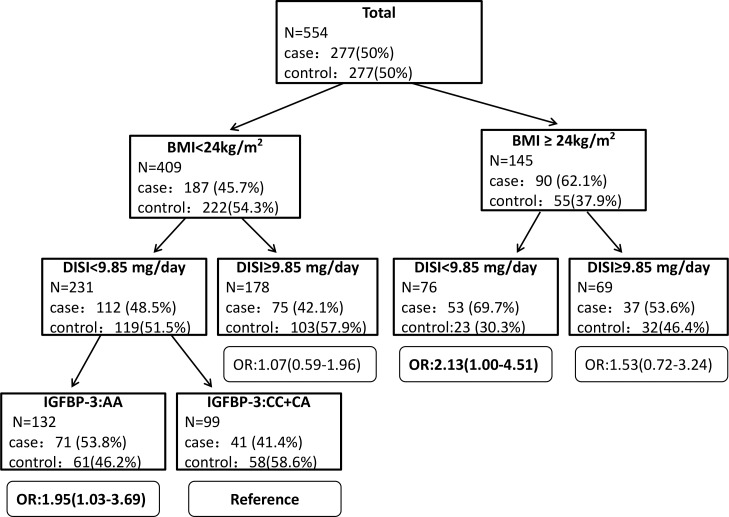
CART analysis of IGF-1 and IGFBP-3 genetic polymorphisms and environmental factors among study participants.After CART analysis, the risk for subgroups identified in different terminal nodes was evaluated using the ULR by treating the subgroup having the smallest percentage of cases as the reference and adjusting for potential confounder factors, including education, income, age at first pregnancy, parity, breast feeding, and energy-adjusted protein, fat, and dietary fiber intake. The results of ULR, ORs, and their 95% confidence intervals for each subgroup are shown by the side of each terminal node of the tree.